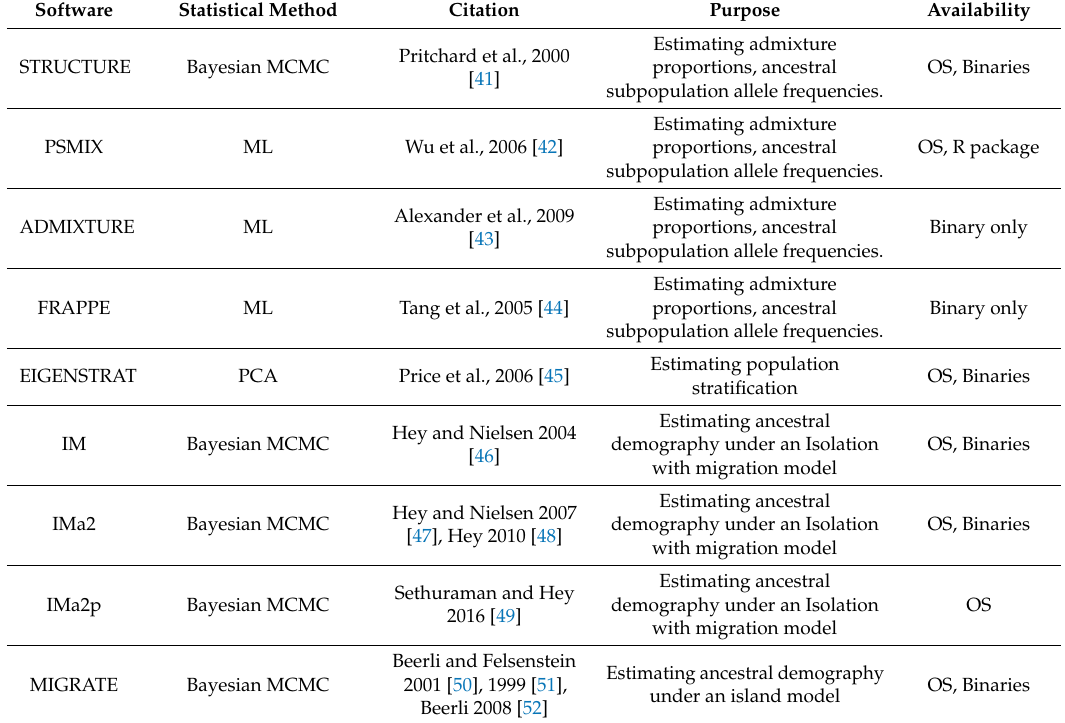
Table 1. List of commonly used population genomics tools for estimating evolutionary history under a variety of